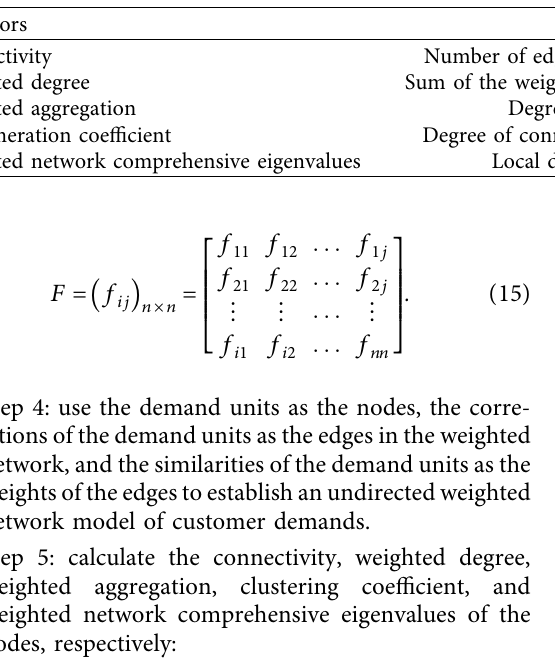
Table 1: Weighted network